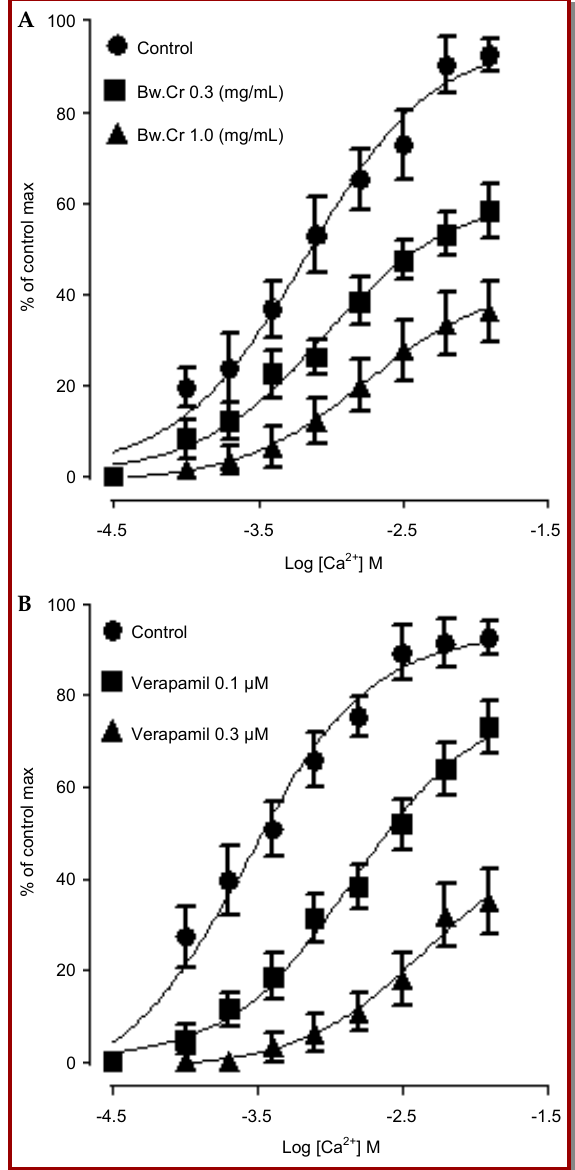
Figure 7 : Concentration – response curves of Ca +2 in the absence and presence of different concentrations of (A) crude extract of B. wallichiana and (B) verapamil in isolated rabbit aorta prepara- tions (values are expressed as mean ± SEM, n =